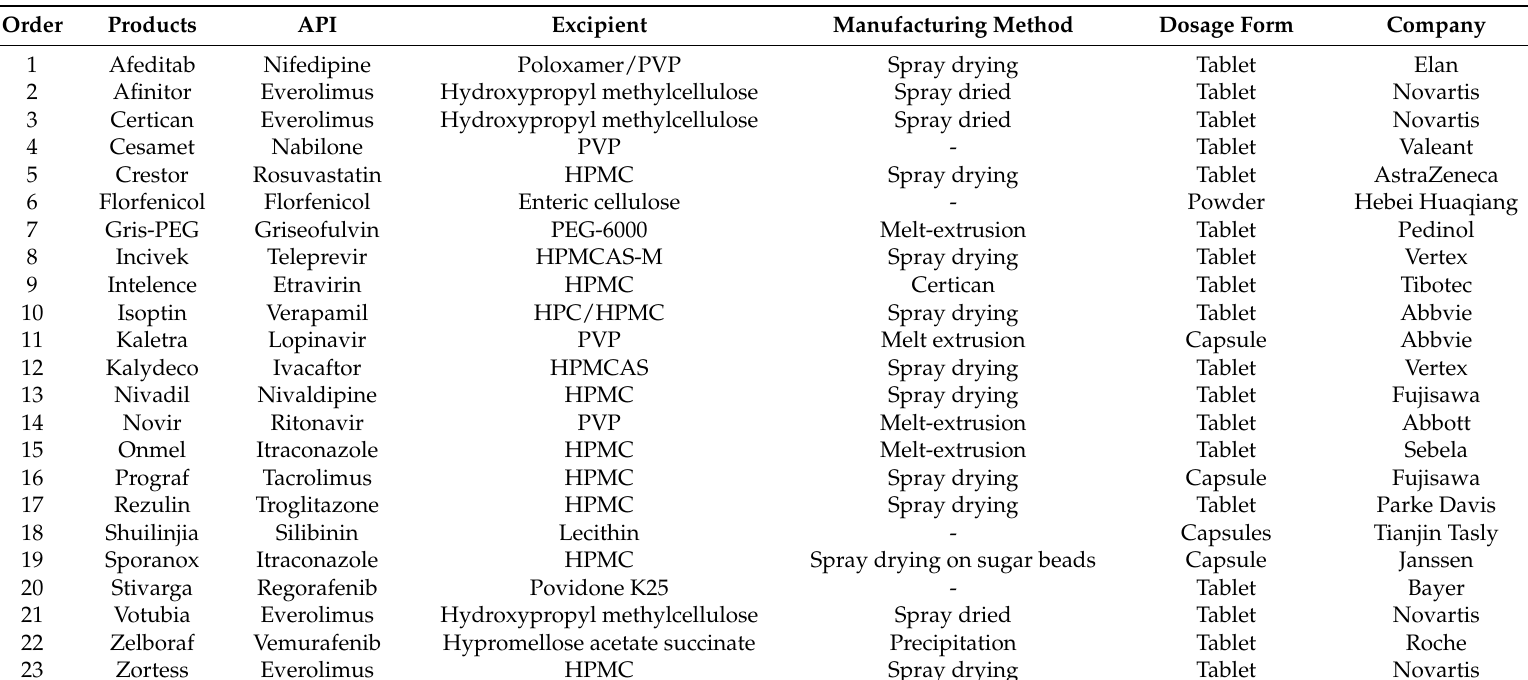
Table 7. Examples of commercially available solid dispersion